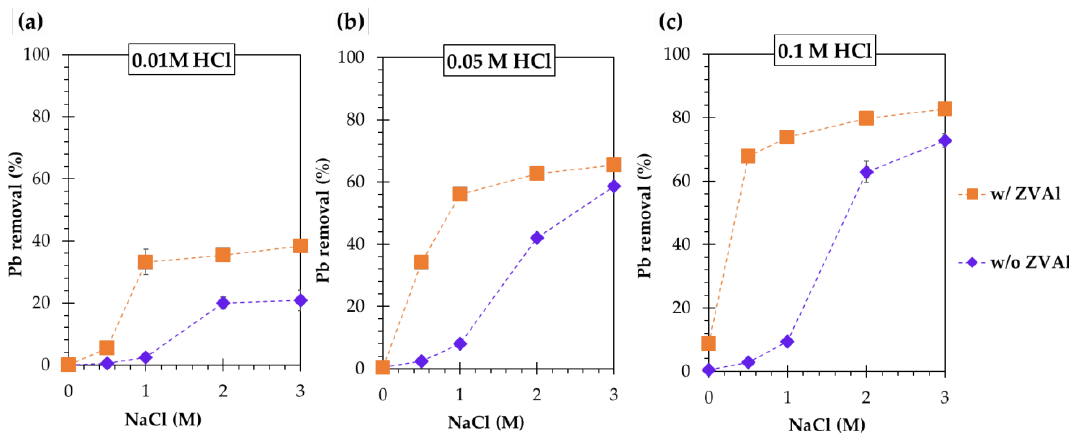
Figure 9. Effects of solution compositions on Pb removal from ZPLRs with and without ZVAl addition: ( a ) 0.01 M HCl and 0–3 M NaCl, ( b ) 0.05 M HCl and 0–3 M NaCl, and ( c) 0.1 M HCl and 0– 3 M NaCl.